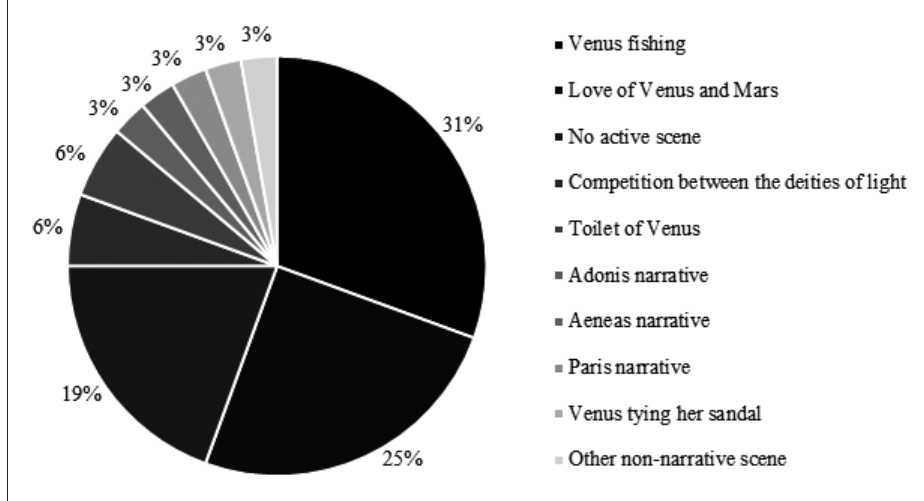
Figure 2: Scene types featuring Venus in small, closed rooms (room types 4 and 12) in domestic contexts in Pompeii – there is a rounding error of